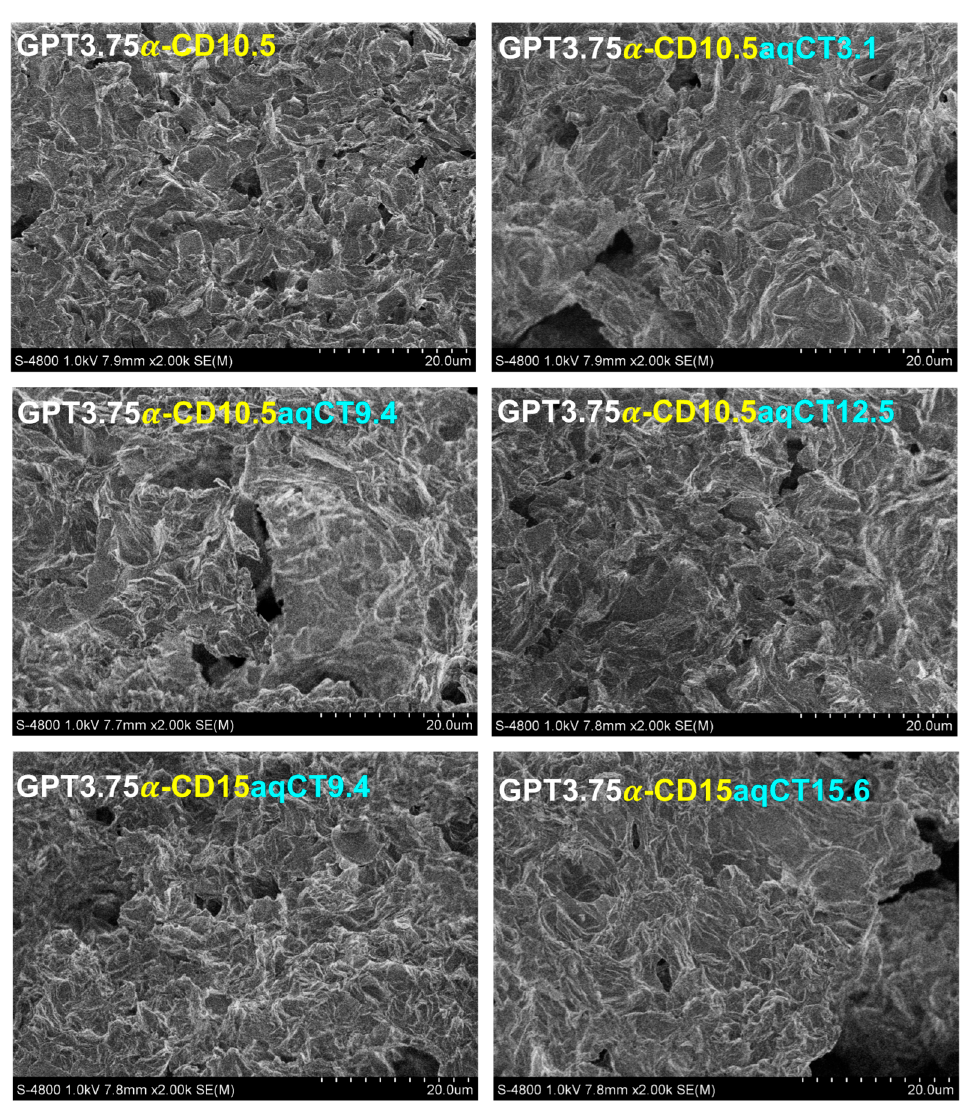
Figure 2. SEM micrographs of the cross-sectional gels, including GPT3.75 α -CD10.5, GPT3.75 α - CD10.5aqCT3.1, GPT3.75 α -CD10.5aqCT9.4, GPT3.75 α -CD10.5aqCT12.5, GPT3.75 α -CD15aqCT9.4, and GPT3.75 α -CD15aqCT15.6.